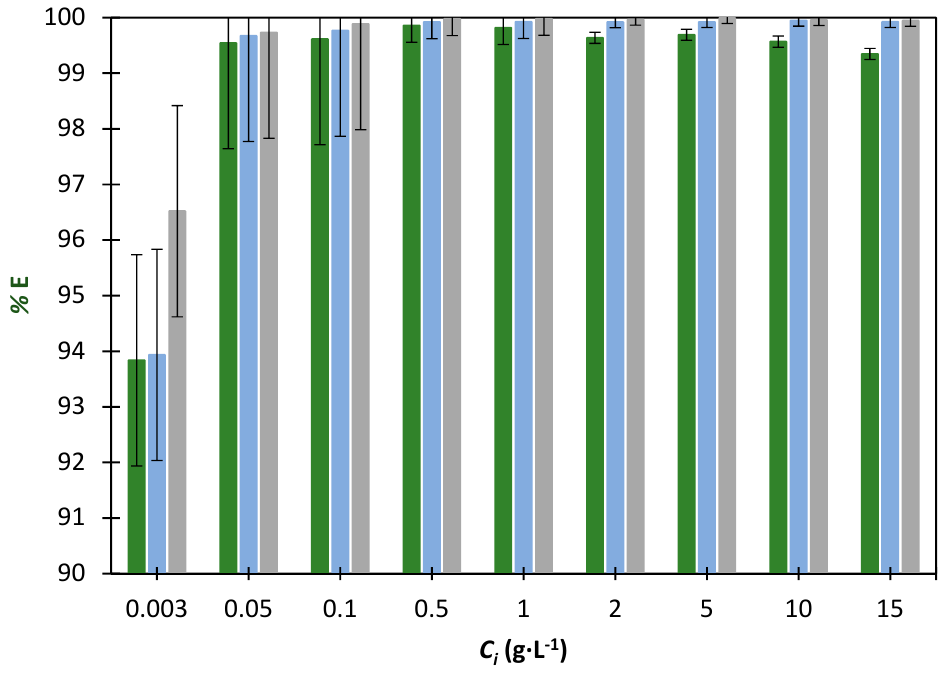
Figure 1. Extraction efficiency ( E %) versus initial concentration ( C ) of phenol ▬ , o-cresol ▬ and 2-chlorophenol ▬ for the extraction using [EMim][DCA] and 20% ( ▬ ) , 30% ( ▬ ) and 40% ( ▬ ) of K PO 3 4